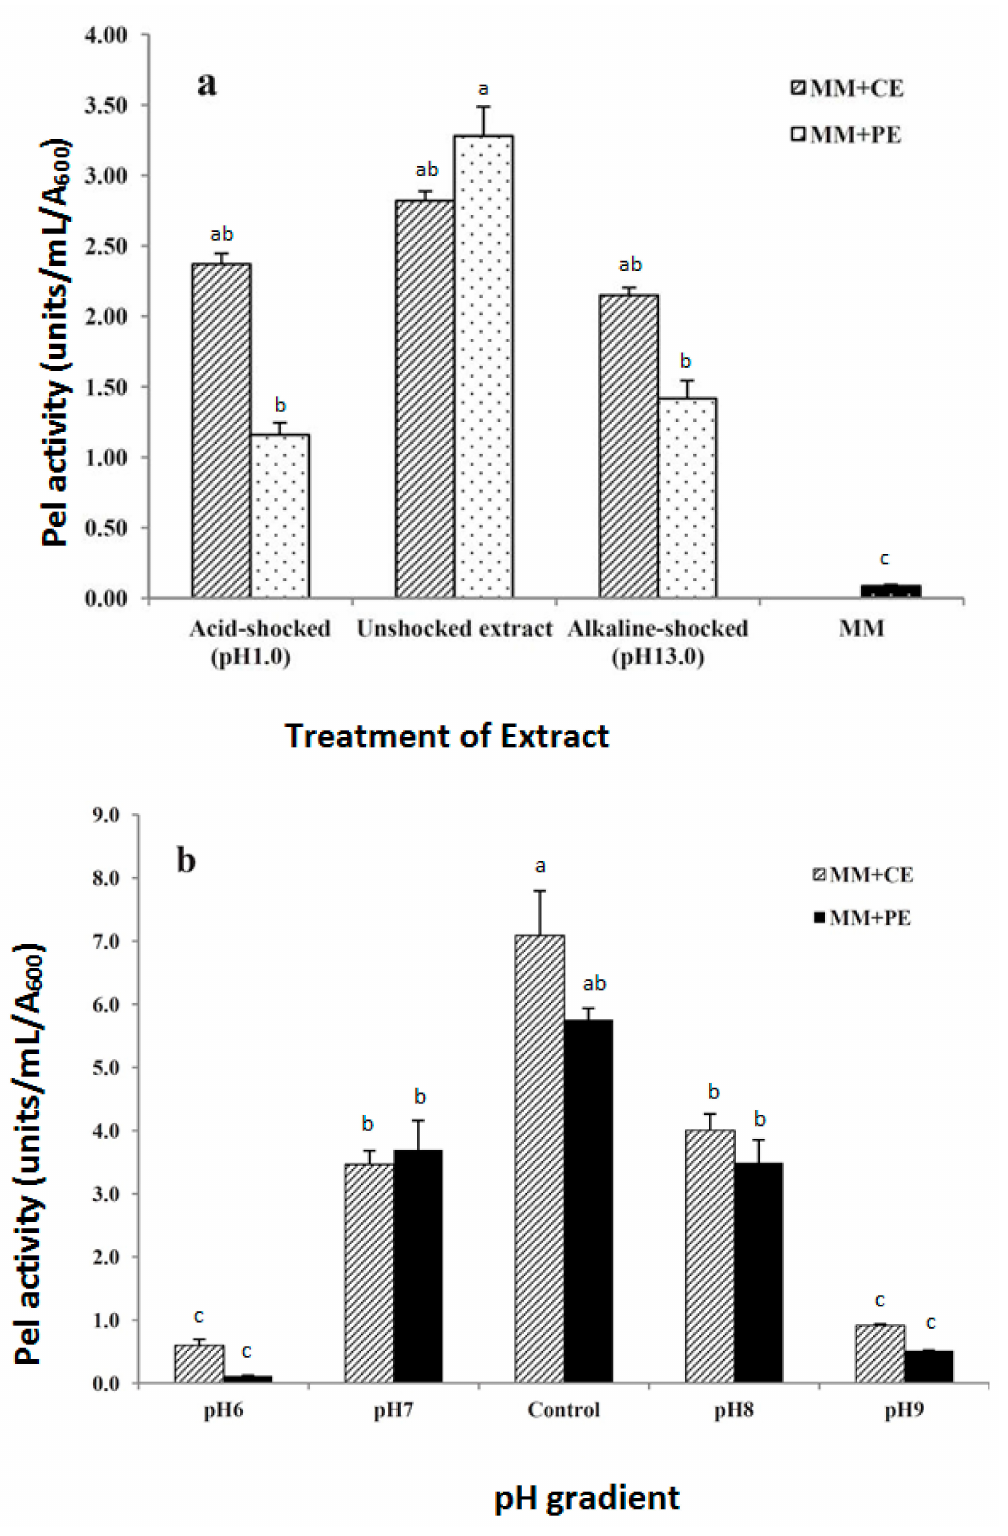
Figure 2. E ff ect of pH on Pel induction. ( a ) The pH of juiced extracts of celery (CE) and potato (PE) were adjusted to either pH 1.0 (acid-shocked) or pH 13.0 (alkaline-shocked) and incubated at 28 ◦ C for 15 min. The pH was readjusted to the original pH (6.19 for CE; 6.25 for PE), filtered and used to supplement MM. ( b ) The pH of extract-supplemented media were adjusted to 6, 7, 8, or 9 and inoculated with bacterial. All experiments were performed in triplicate, and the mean values ± SD (indicated as error bars) are presented. Means with same letters are not significantly di ff erent by Student’s t -test at P <